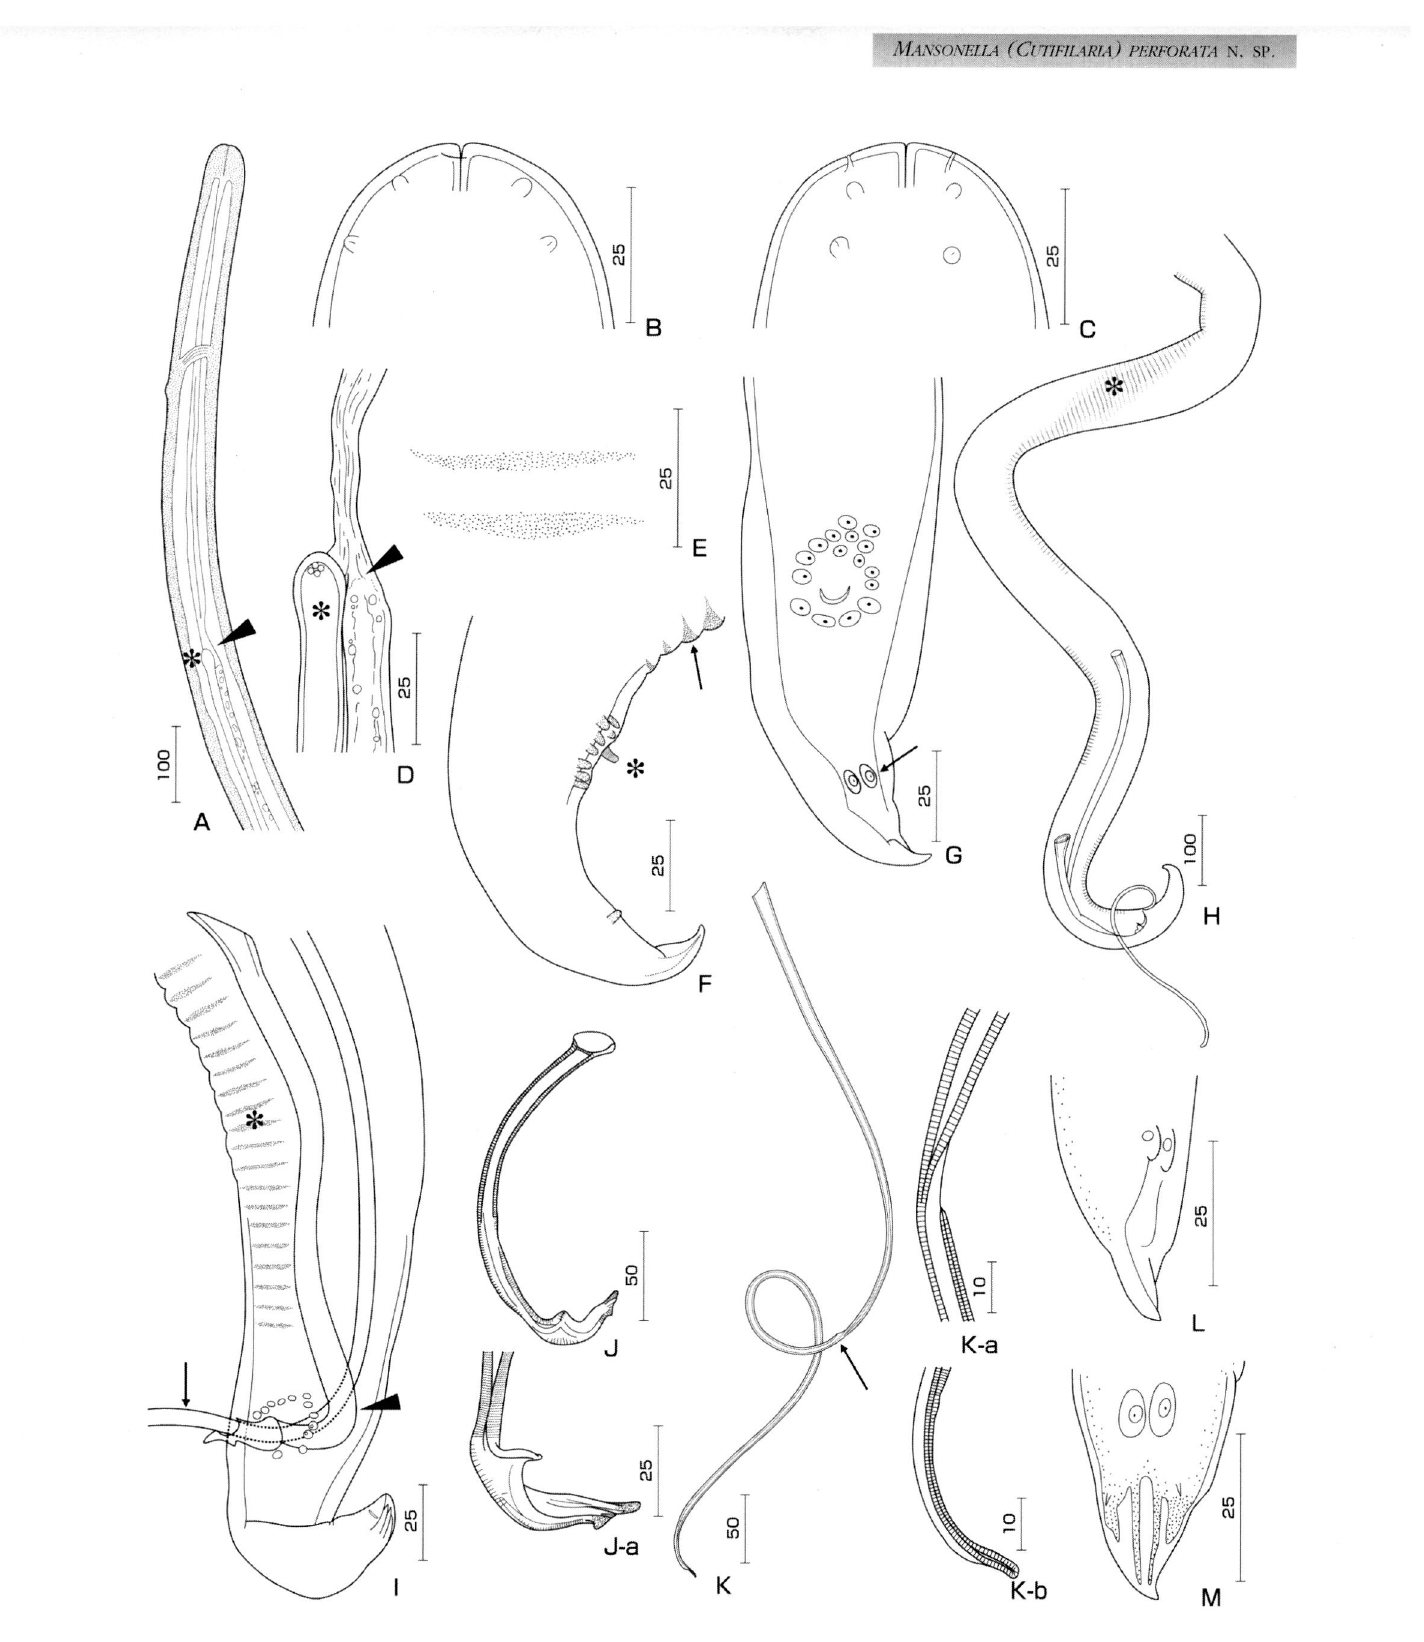
Fig. 10. - M. (C.) perforata n. sp. A-M, males. A. Anterior part, apex of testis (*) and esophagointestinal junction (arrowhead). B. Head, lateral view. C. Head, median view. D. Apex of testis (*) and esophagointestinal junction (arrowhead). E. Area rugosa, transverse bands composed of tiny points. F. Posterior part, lateral view. Area rugosa (arrow). Posterior end of right spicule (*). G. Posterior part, ventral view. A pair of large papillae (arrow). H. Posterior part, area rugosa (*), right spicule, and left spicule (the posterior part outside the cloaca). I. Posterior part, left spicule (arrow) next to right spicule (arrowhead) at the cloaca. J. Right spicule, lateral view. J-a. Right spicule, pos terior part. K. Left spicule, handle-lamina junction (arrow). K-a. Enlarged handle-lamina junction of left spicule. K-b. Posterior end of left spicule. L. Caudal end. lateral view. M. Caudal end. ventral view. Bars, micrometers.